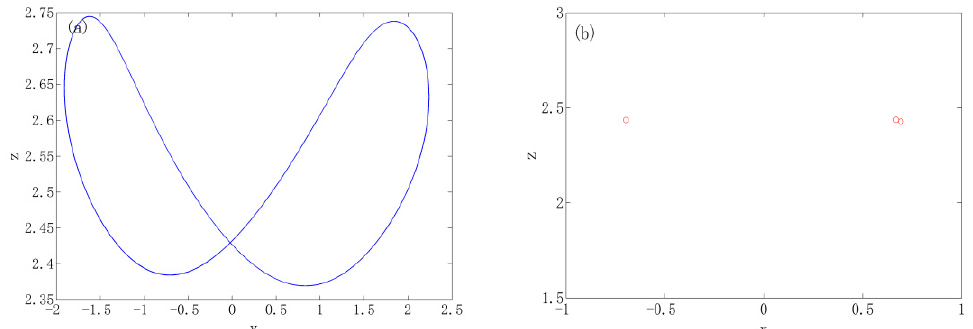
Figure 1. Hidden chaotic attractor of system (4) when α = 0.28. ( a ) Phase trajectory diagram in yz plane; ( b ) Poincare map in xz plane.